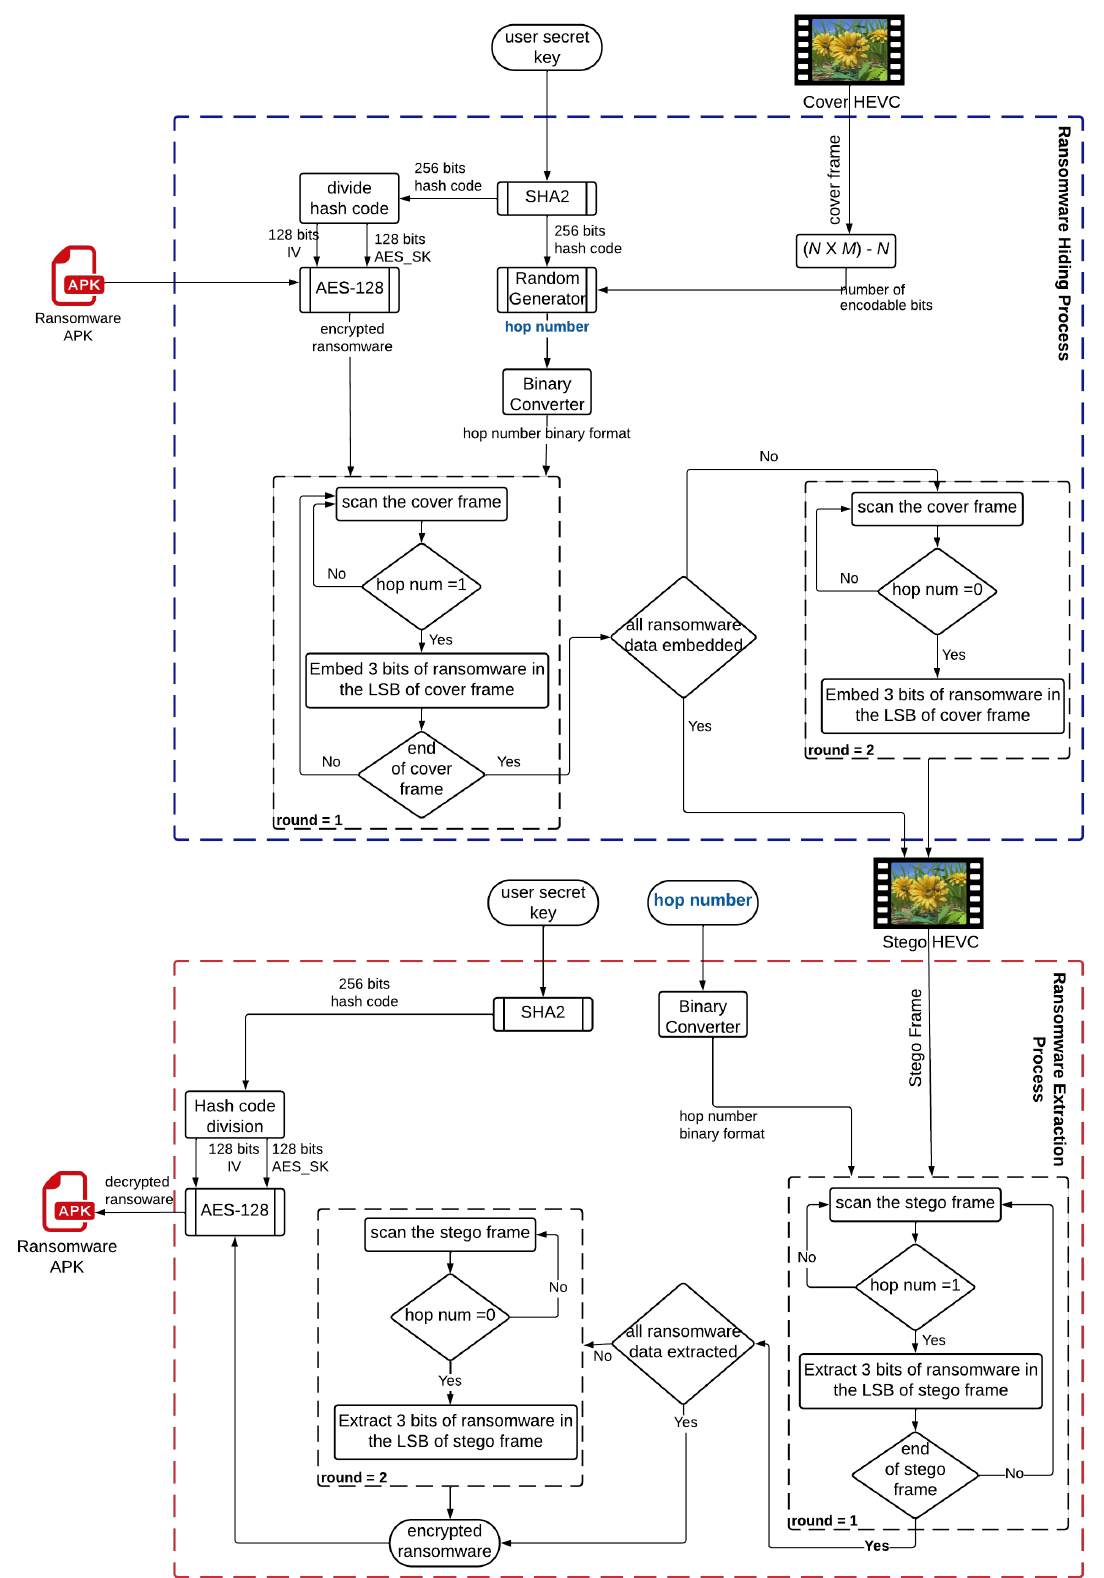
Figure 1. Proposed hiding/extraction stages of the crypto-steganography